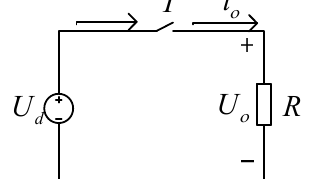
Figure 2. DC converter circuit.